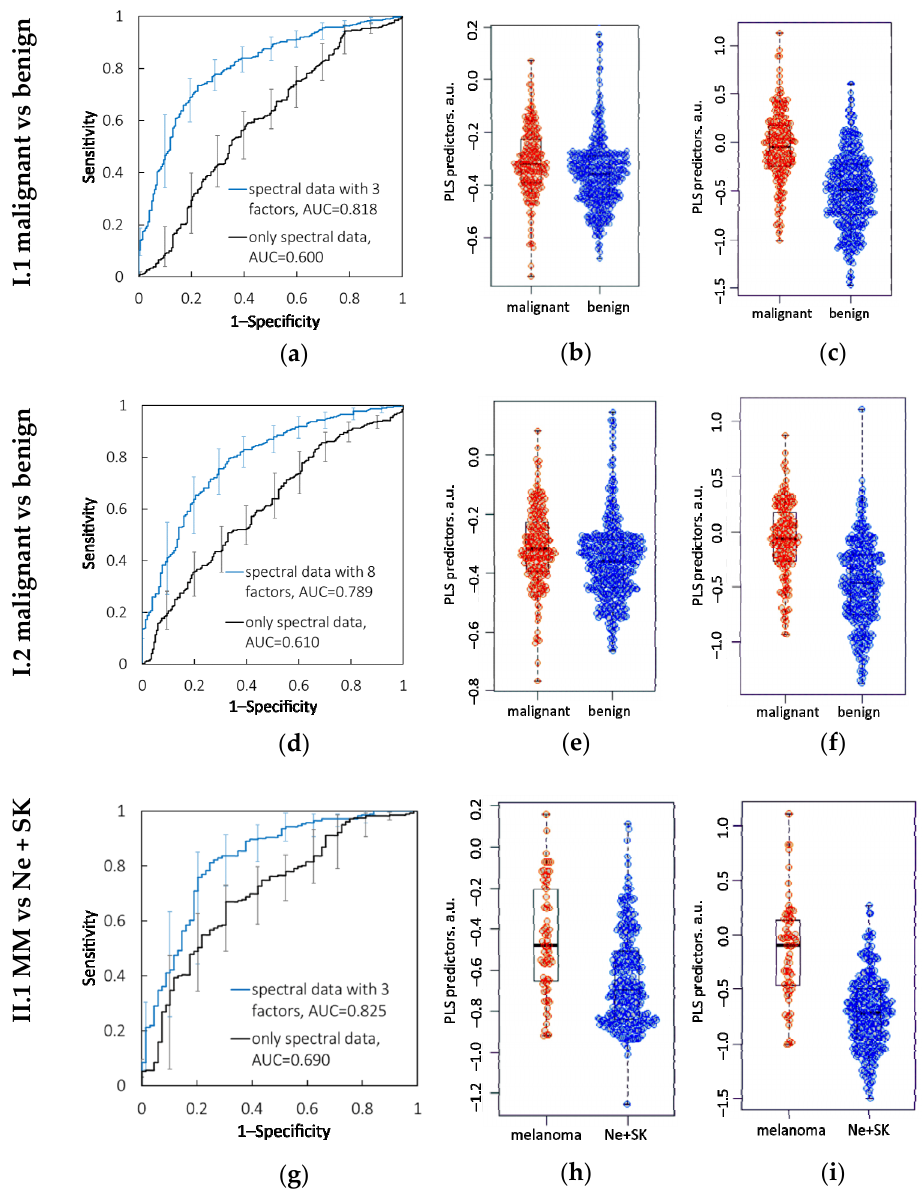
Figure 2. Results of diagnostic models with statistical significance ( p < 0.05). I.1: Malignant vs. benign neoplasms: ( a ) ROC AUCs, bee-swarm diagrams of PLS predictors for tumor classification based on ( b ) spectral parameters and ( c ) combination of spectral parameters and three patient factors. II.1: Malignant vs benign neoplasms: ( d ) ROC AUCs, bee-swarm diagrams of PLS predictors for tumor patient factors. I.2: MM vs benign pigmented neoplasms: ( g ) ROC AUCs, bee-swarm diagrams of